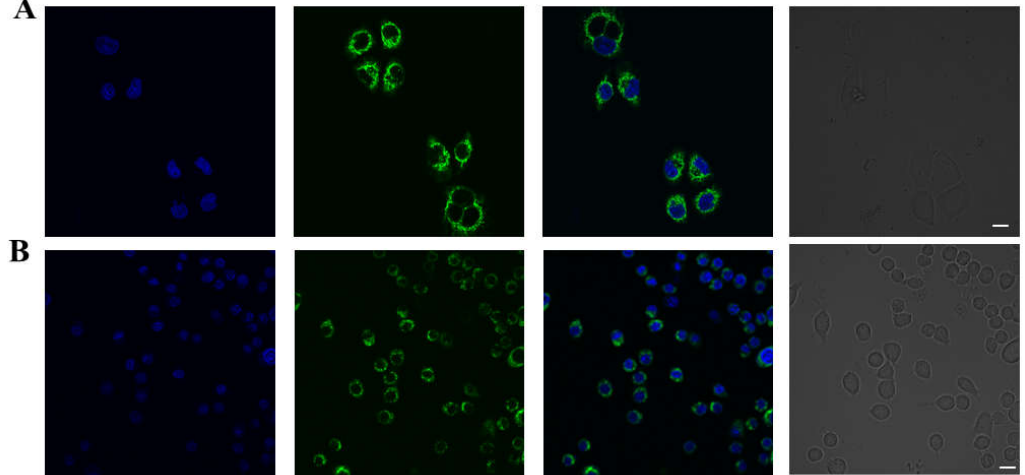
Figure 6. Fluorescence image of ONOO − in the cytoplasm of HepG2 cells. Cells were stained with 10 µ M HDBT-ONOO − or costained with 10 µ M DAPI for 60 min, and then stimulated with 1.2 mM SIN-1 for another 90 min before imaging. ( A ) (left to right) DAPI in HeLa cells, probe + SIN-1, DAPI + probe + SIN-1, bright-field image of ( A ); ( B ) (left to right) DAPI in RAW 264.7 cells, probe + SIN-1, DAPI + probe + SIN-1, bright-field image of ( B ). The images were acquired using a fluorescent microscope (green channel with 458 nm excitation and 520–590 nm collection, a blue channel with 405 nm excitation and 430–480 nm collection). Scale bar: 30 µ m.